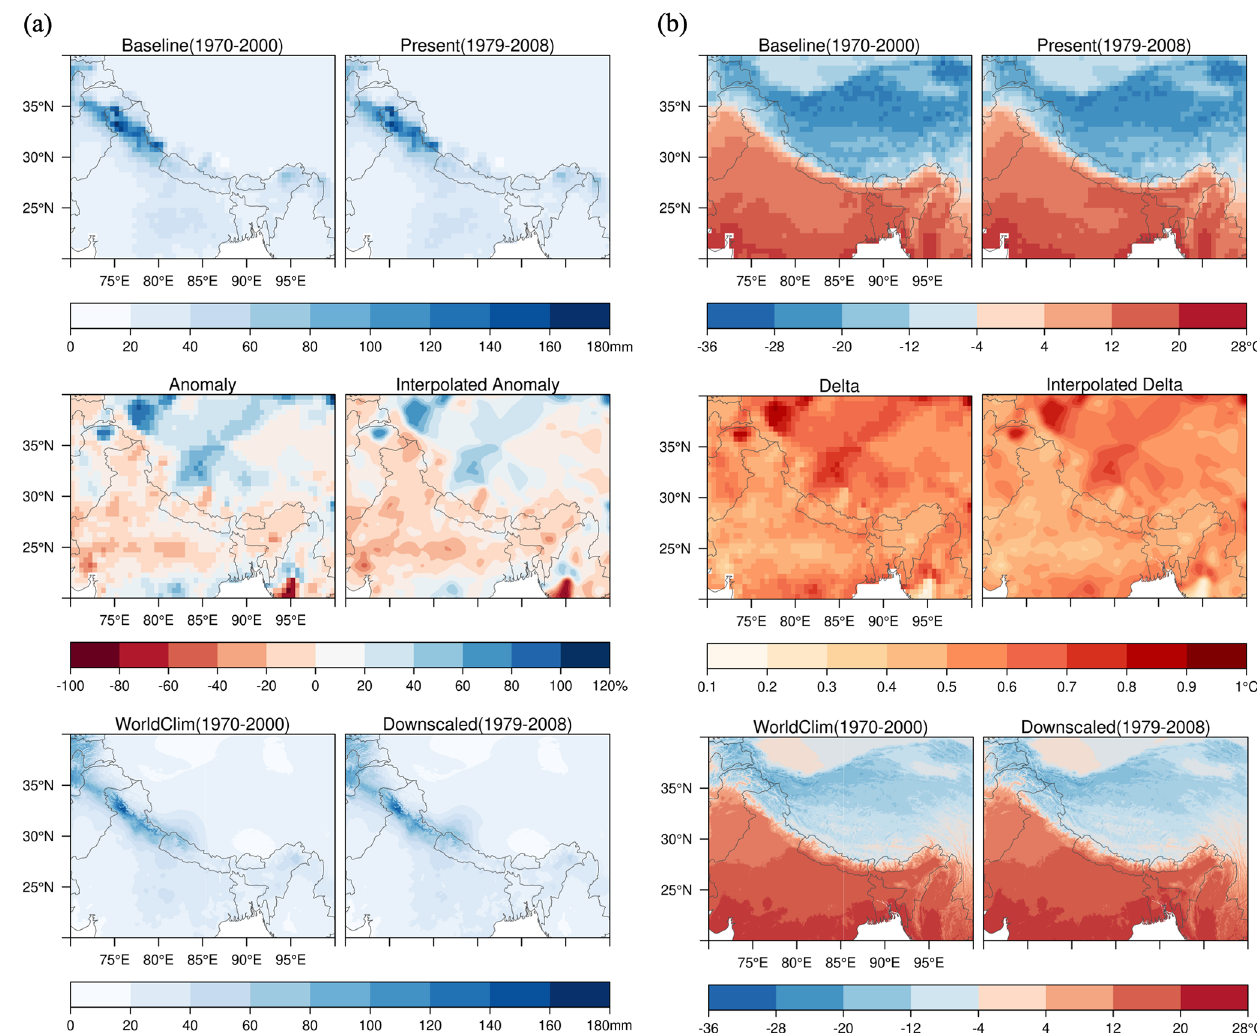
Figure 1. Illustration of the downscaling process. (a) Anomaly downscaling method with January total precipitation from GPCC dataset and (b) delta downscaling method with January temperature from CRU dataset. Baseline (1970–2000) and present-day climate data (e.g., 1979–2008) are from CRU, UDEL, or GPCC datasets, which have a coarse spatial resolution of 0.5 ◦ . Precipitation anomaly is change factor of monthly precipitation from baseline to present-day climates. Temperature delta is change in monthly air temperature from baseline